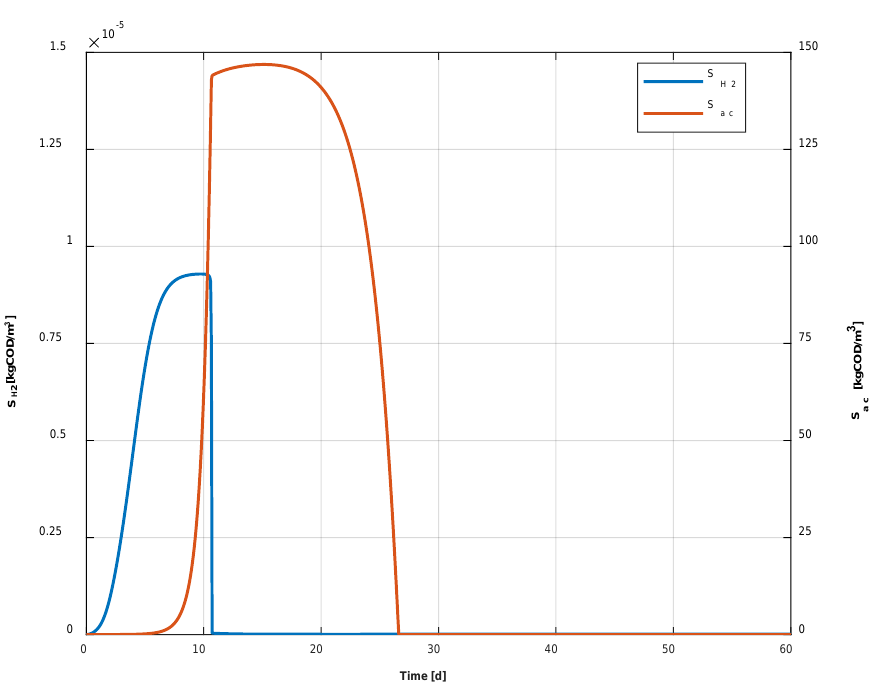
Figure 4. Concentration of H 2 and acetate at the end of PRF. 294 The biogas produced, shown in Figure 5, follows, as expected, the trend of S CH4 .